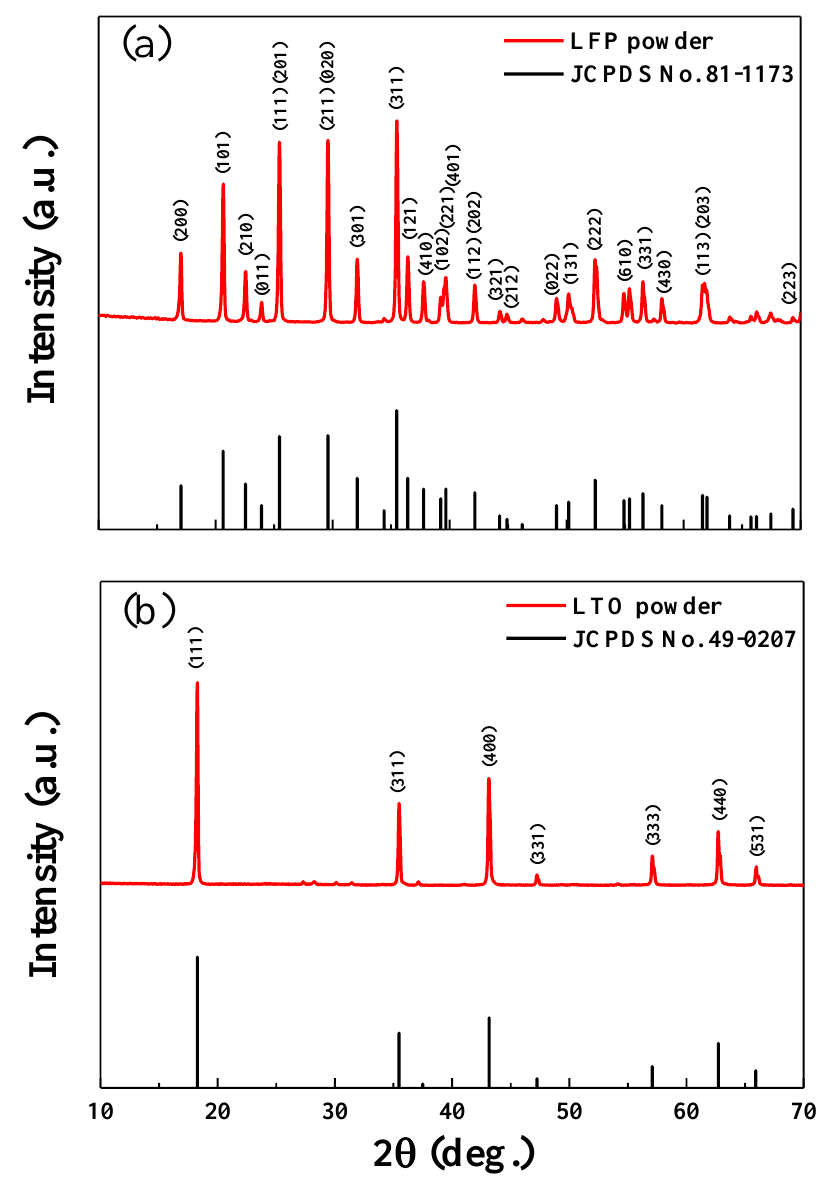
Figure 3. XRD patterns of ( a ) LiFePO 4 powder and JCPDS card No. 81-1173 and ( b ) Li 4 Ti 5 O 12 powder and JCPDS card No. 49-0207.